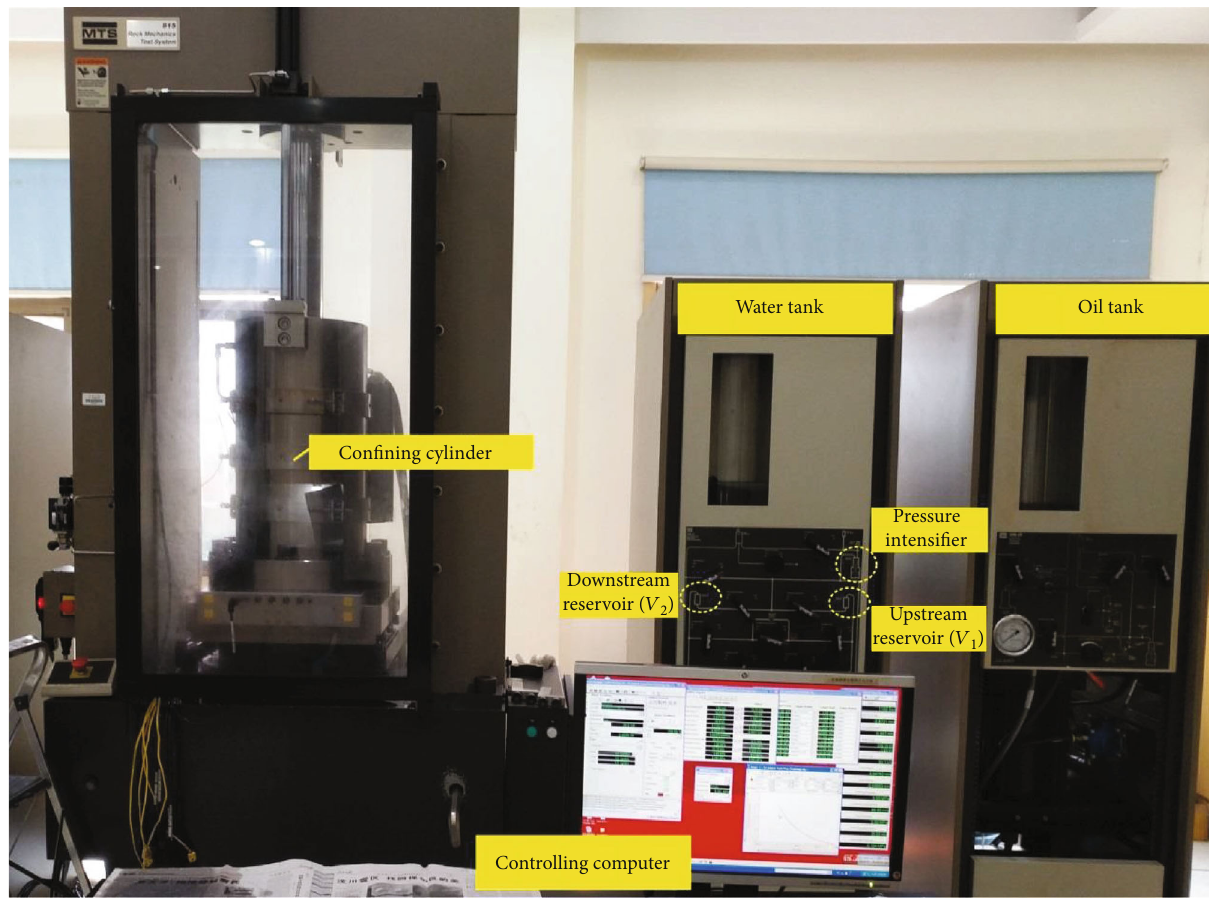
Figure 2: Schematic of transient permeability